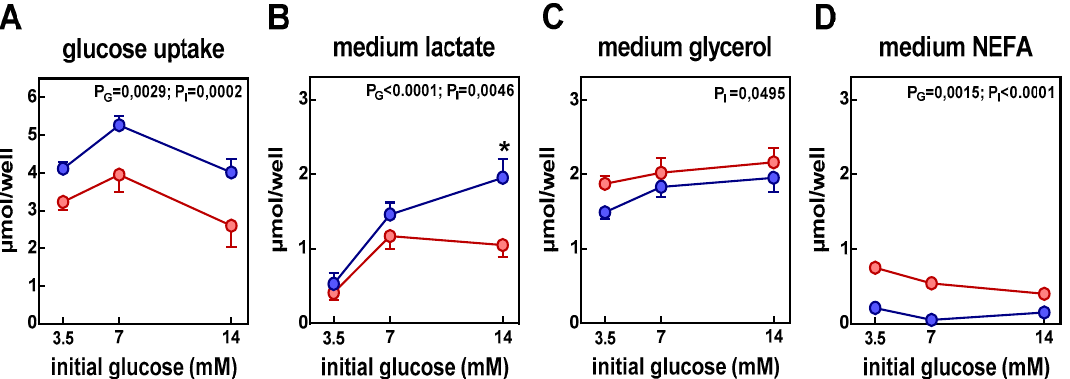
Figure 1. Effect of insulin on the rates of glucose uptake and other metabolite efflux after the incubation of adipocytes for 24 h with 3.5, 7, or 14 mM glucose. The data are the mean ± SEM from 12 different animals. Values are expressed as µ mol per well of ( A ) glucose taken, or ( B ) lactate, ( C ) glycerol, and ( D ) NEFA (non-esterified fatty acids) released to the medium after 24 h of incubation. Red circles: adipocytes incubated in absence of insulin; blue circles: adipocytes incubated in presence of insulin. Statistical significance of the differences between groups (2-way ANOVA): P G corresponds to the differences with respect to initial glucose, and P I corresponds to the differences with respect to the presence or not of insulin. Not significant values ( p > 0.05) were not represented. *post-hoc significant differences between groups with and without insulin of identical glucose concentration.